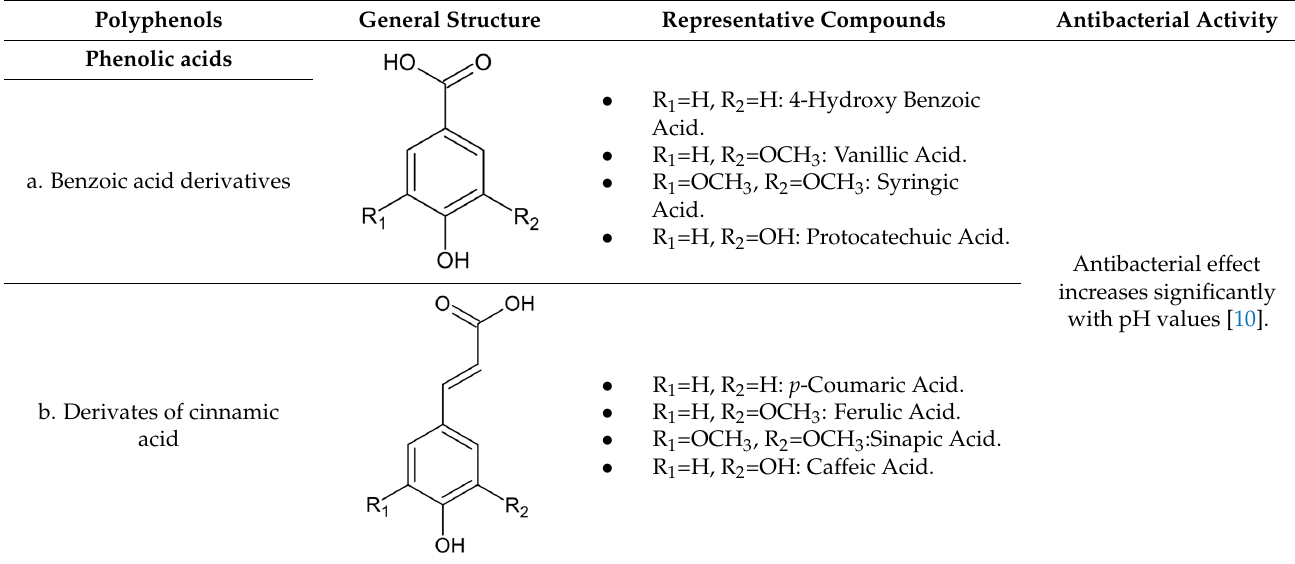
Table 1. Classification of natural phenolic compounds.